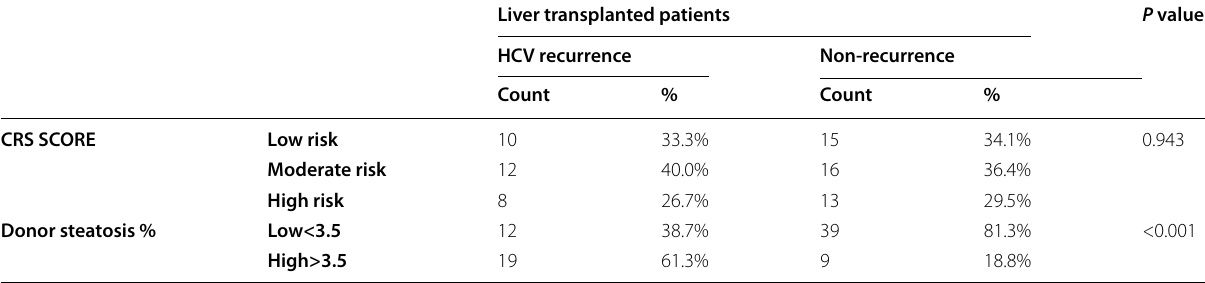
Table 7 Frequency of HCV recurrence among CRS categories; donor steatosis groups. CRS subgroups are high risk, CRS > 0.7; moderate risk, CRS 0.5–0.7; low risk, CRS < 0.5